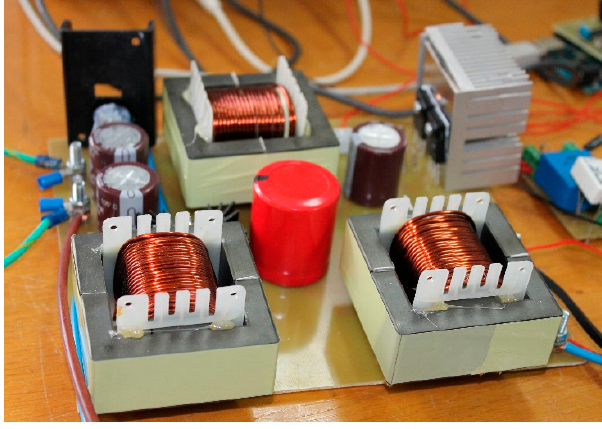
Figure 6. Experimental prototype. Table 2. ISF-250 model. Performance at an irradiance of 1000 W/m 2 and cell temperature of 25 °C.